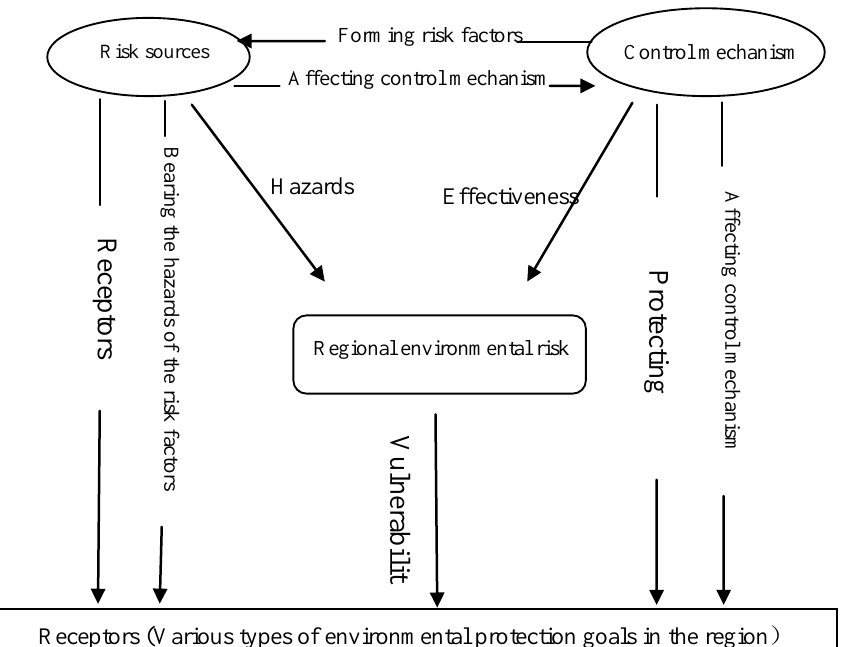
Figure 2. Relationships among the components of the environmental risk